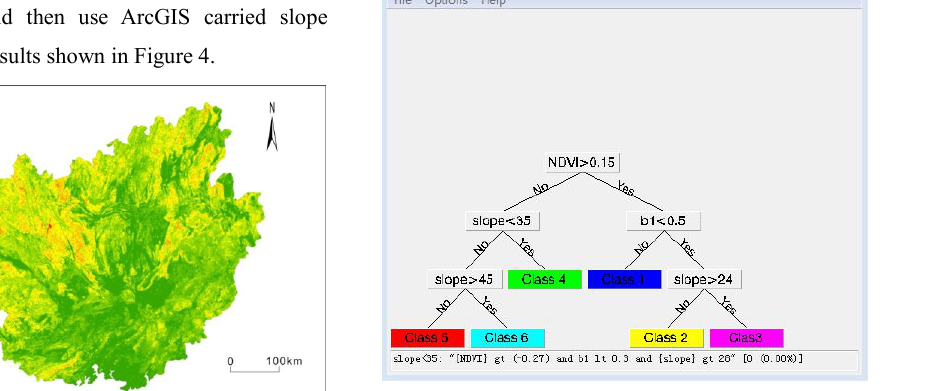
Figure 5. Decision tree classification rule base Which, b1 and slope, respectively, the vegetation coverage and slope, 1-6 rocky represent different levels, in turn means no rocky, potentially rocky, rocky mild, moderate desertification, strength rocky and extremely rocky. As it relates to the whole area in Guangxi, the situation in the classification process misclassification, so the need for initial classification of the image can be corrected. Using 5, 4, 3 false color composite image at the right or wrong of correction, and then combined with Google Earth corrected. The main areas misclassified as bare soil mountain region, image features in such areas and image features in rocky desertification areas shown in Figure 6. Results of the initial classification by Google Earth would be wrong type of correction, the final classification results combined into a map (Figure 7).